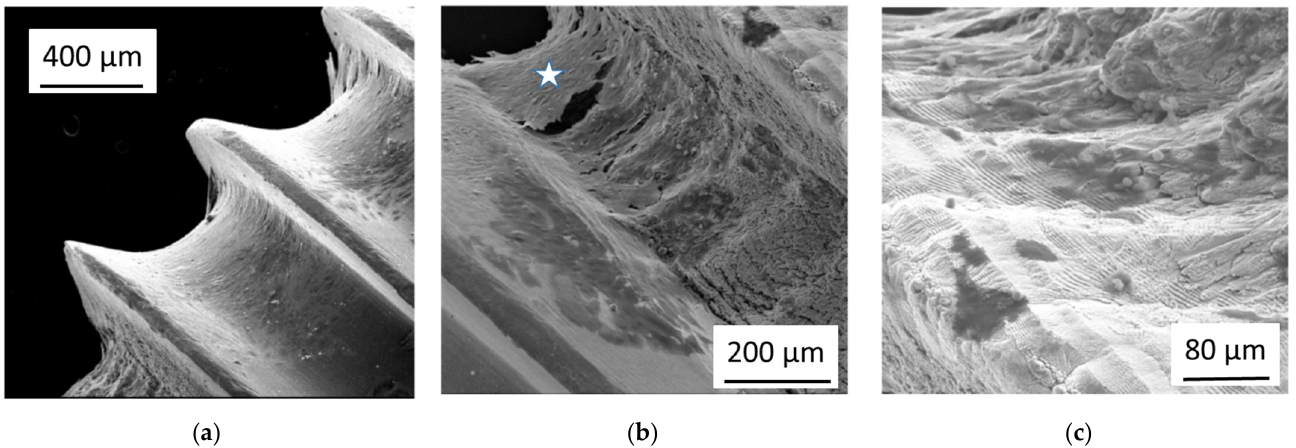
Figure 6. Electron microscope images of ( a ) a pre-anodized Ti-based bone screw overgrown by osteoblasts after 3 weeks in culture and ( b ) of a femtosecond laser-treated area on the same screw, where many areas remain cell-free. ( c ) shows a detail of ( b ) in higher magnification.